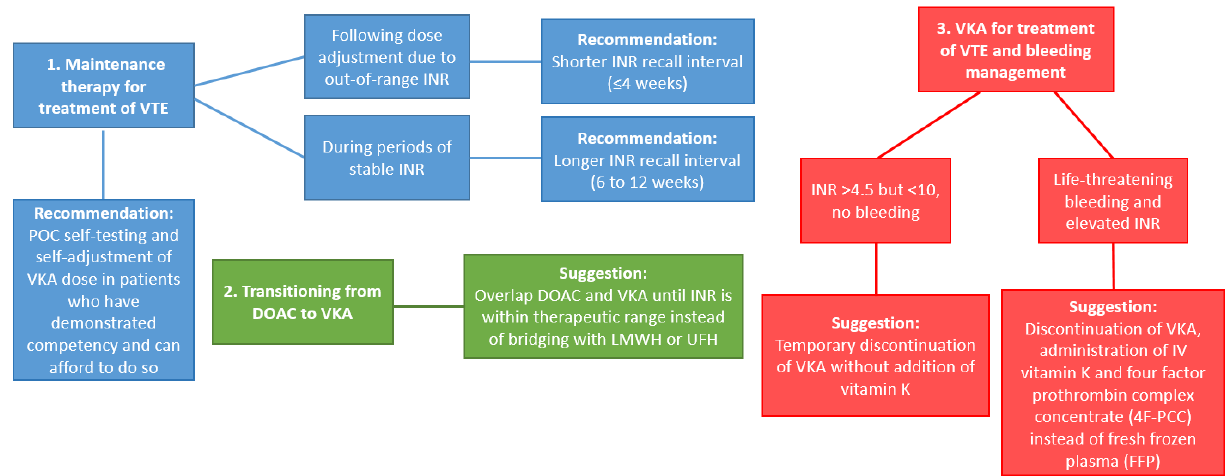
Figure 1. Updates to recommendations for VKA management (Based on ASH guidelines [22]). Abbreviations: VTE: venous thromboembolism; POC: point-of-care; VKA: Vitamin K antagonists; INR: international normalized ratio; DOAC: Direct oral anticoagulant; LMWH: low molecular weight heparins; UFH: unfractionated heparin.